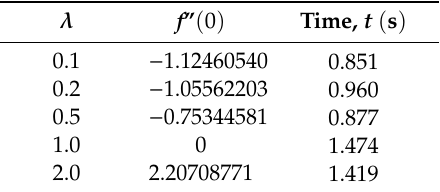
Table 3. Computational time to generate the values of f (cid:48)(cid:48) ( 0 ) as λ varies when φ 1 = φ 2 = 0, γ = 0, ε = 1, M = 0, A = 0, and Pr =